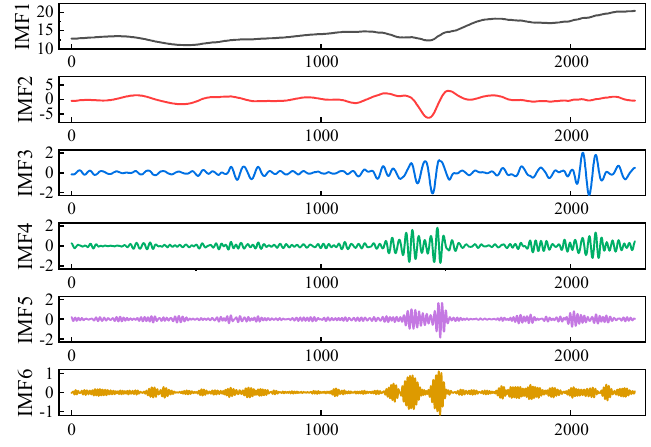
Figure 6. The VMD decomposition of the UP17 measurement point. Table 3. The sample entropy values of the UP17 measurement point.